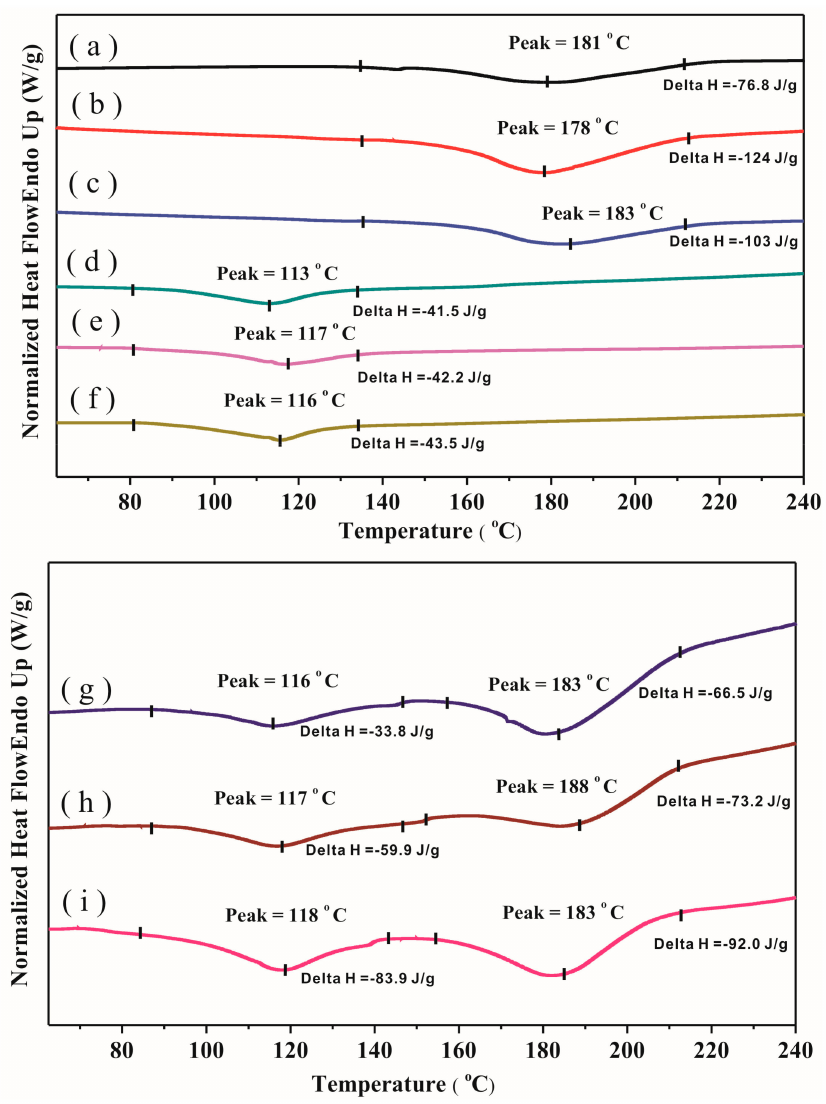
Figure 4. DSC thermograms of ( a – c ) Px–MMA (x = 1–3) with 1.0 wt. % TBCP, ( d – f ) Px–MMA/HP7200 blend (x = 1–3) with 0.5 wt. % DMAP, and ( g – i ) Px–MMA (x = 1–3) with 1.0 wt. % TBCP and 0.5 wt. %